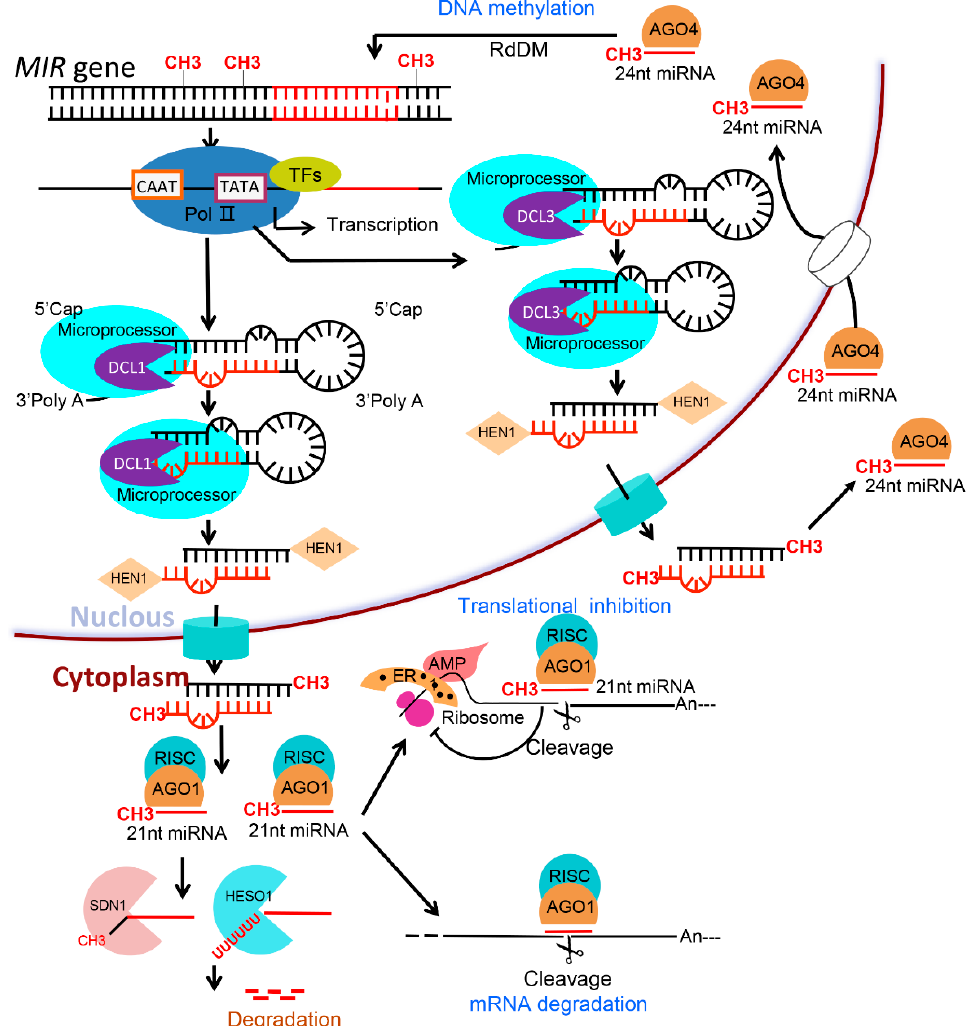
Figure 1. An overview showing micro RNA (miRNA) biogenesis and functioning in plants. MIRNA genes are transcribed to form primary miRNAs, from which 21 and 24 nt miRNAs are processed by DCL1 and DCL3, respectively. Their 3 ′ ends are methylated by HEN1. While the 21 nt species are involved in cleavage or translational inhibition of the target mRNAs, the 24 nt miRNAs are involved in DNA methylation.